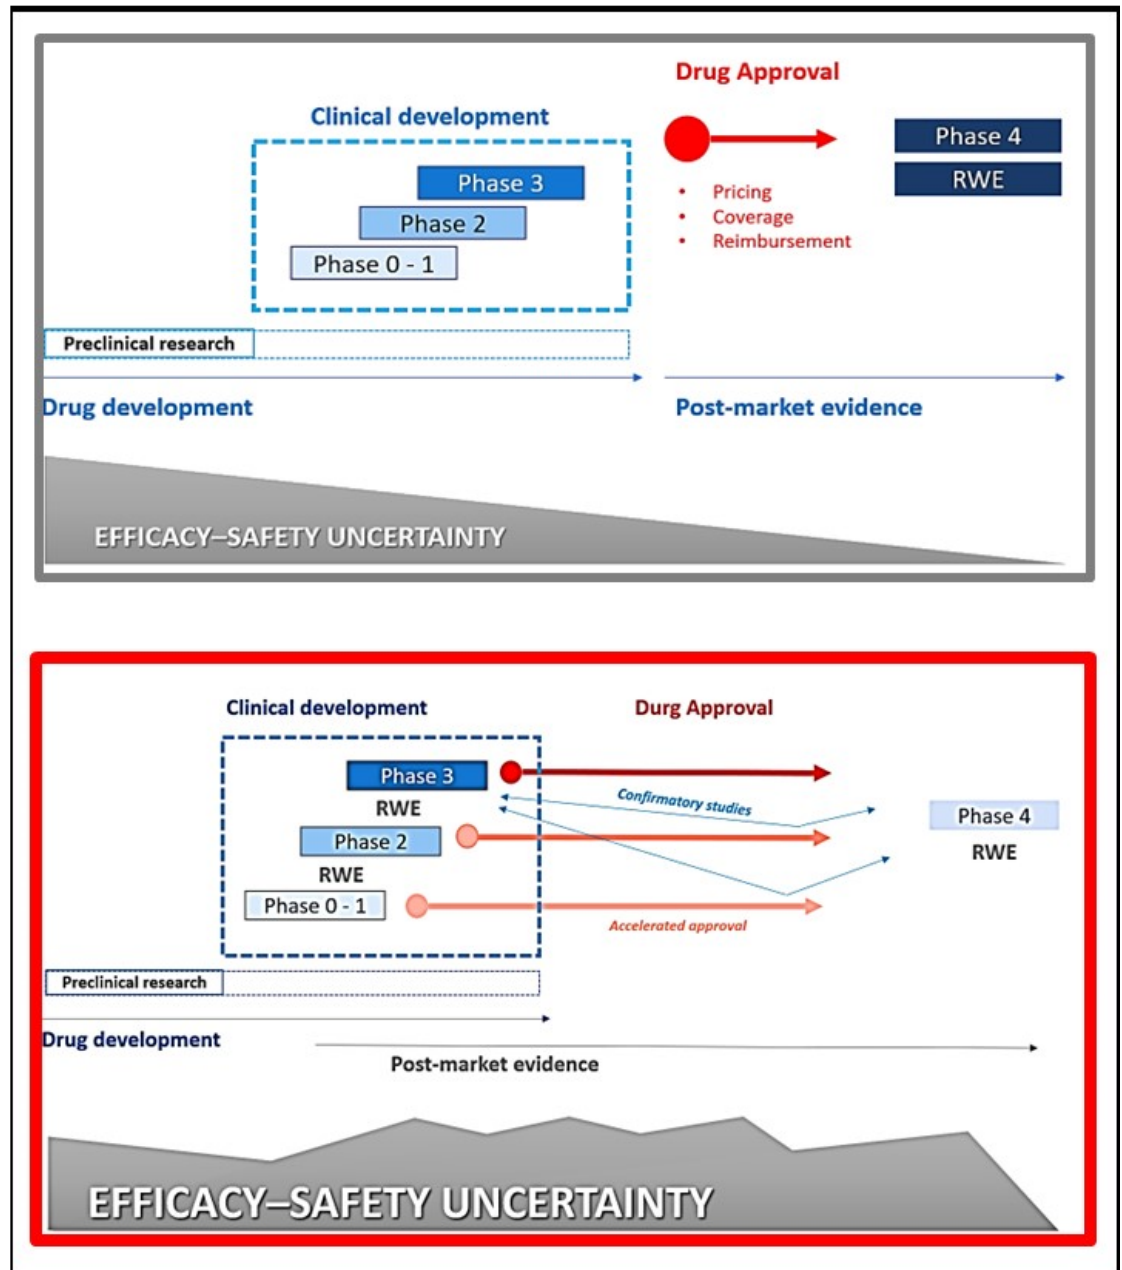
Figure 3. Drug development scenarios and potential impact on efficacy-safety data. In the upper panel: standard drug development; in the lower panel: potential impact of accelerated drug approvals and new trial designs on the efficacy-safety data. RWE, real-world evidence .